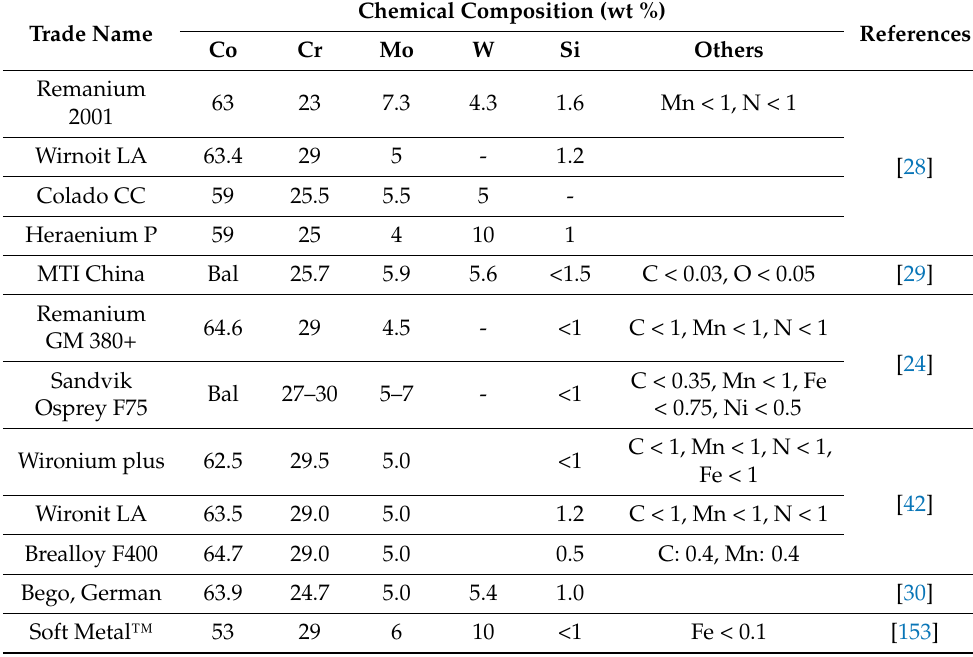
Table 4. Chemical composition of Co-Cr alloys commonly used for dental